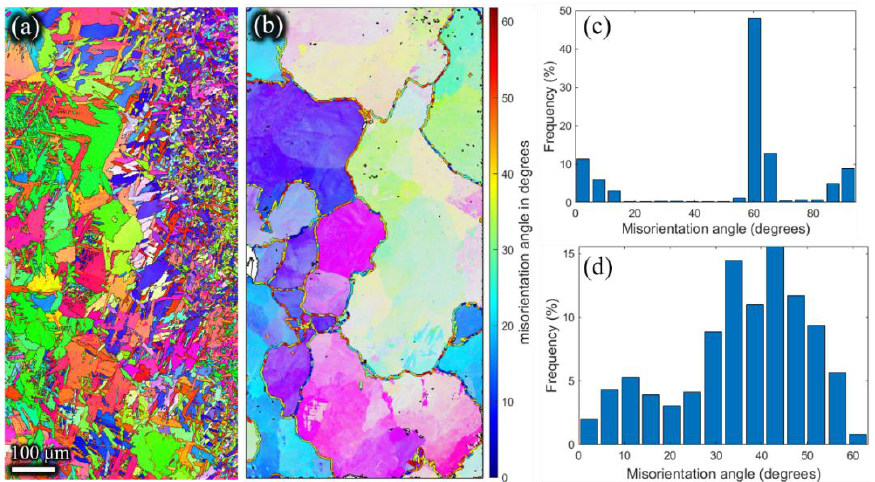
Figure 12. Inverse pole Figures of ( a ) the α phase, and ( b ) the reconstructed β phase. Misorientation angle of ( c ) α grains, and ( d ) reconstructed β grains of the residual deformed billet with a holding time of 60 s.